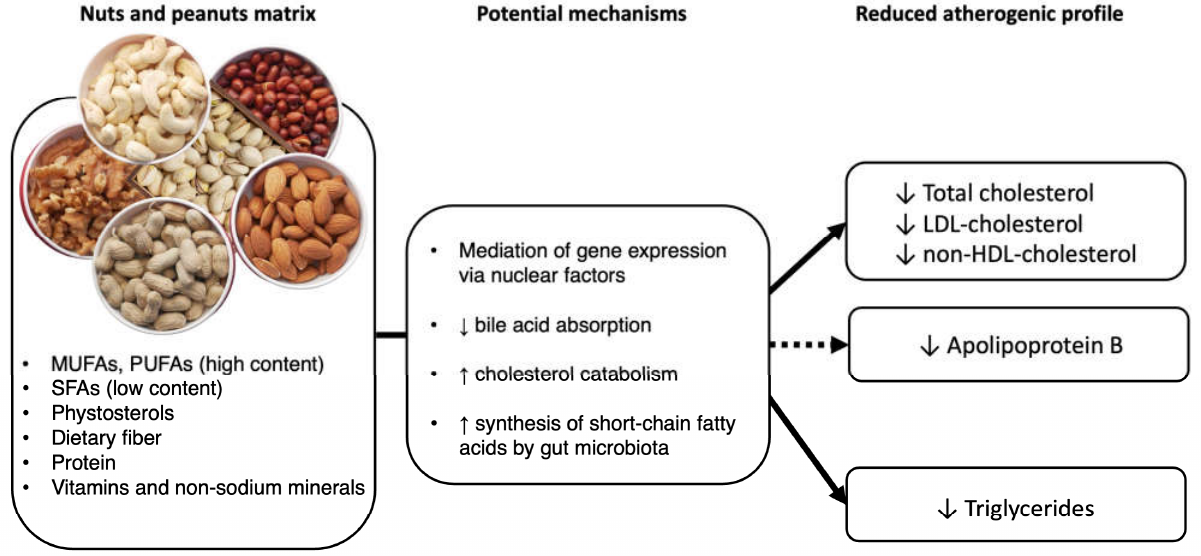
Figure 1. Potential mechanisms by which tree nuts and peanuts reduce atherogenic lipid/lipoprotein profile. A plain arrow indicates a strong level of evidence to support the effect, whereas a dashed arrow indicates a lower level of evidence. LDL, low density lipoprotein; HDL, high density lipopro- tein.